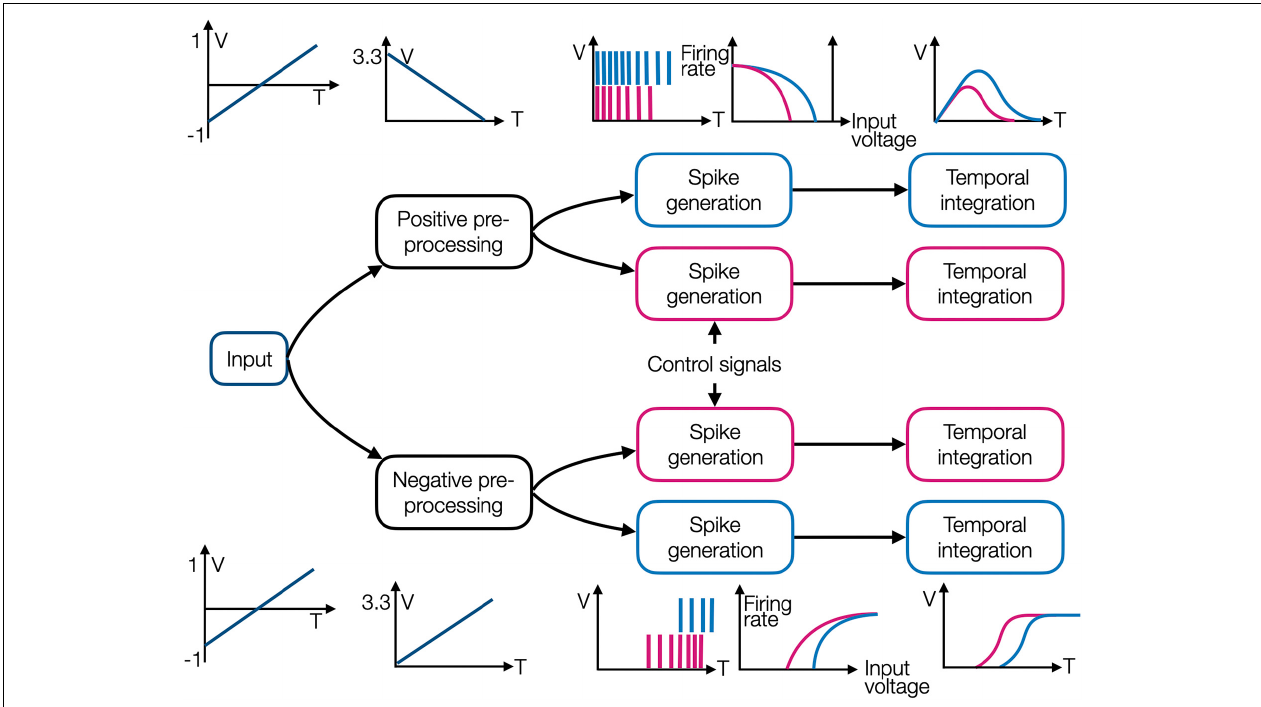
FIGURE 2 | An illustration of four OZ neurons grouped into two branches, one with positive and the other with negative encoders. Each branch initiates with an input preprocessing module, and each neuron comprises a spike generation and temporal integration modules. Each neuron has different tuning, and it is therefore producing spikes in a different